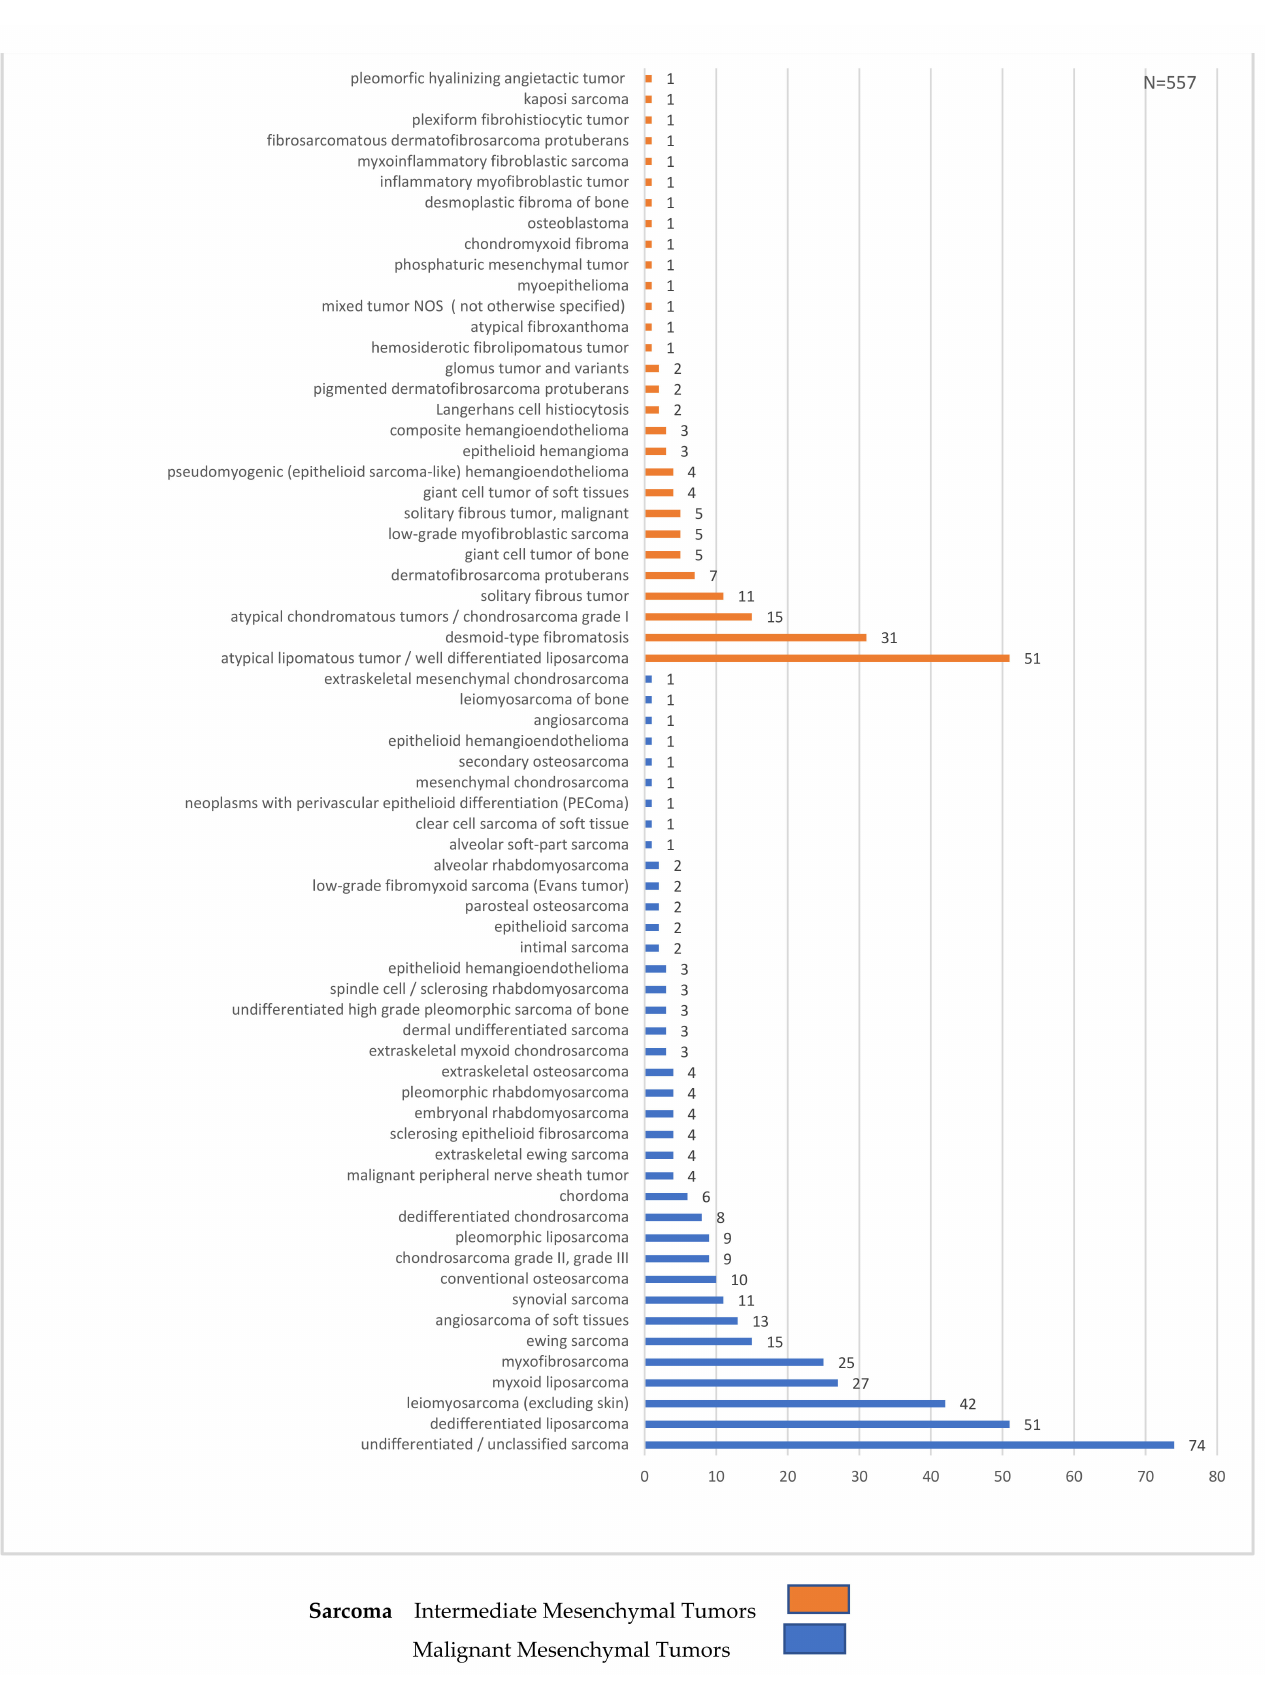
Figure 3. Histological types of sarcoma